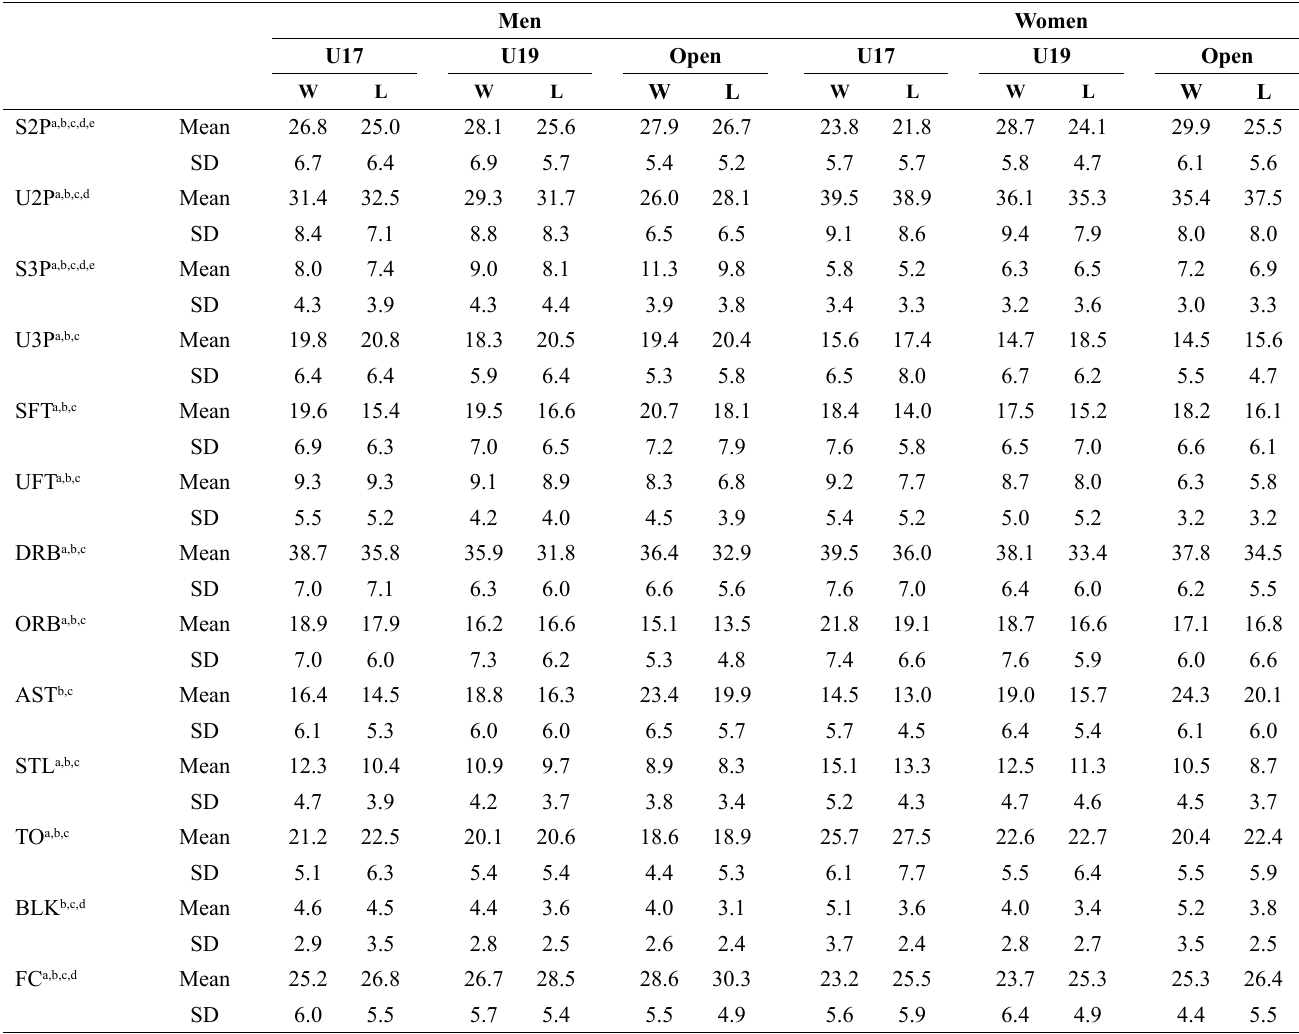
Table 2. Game-related statistics of balanced games